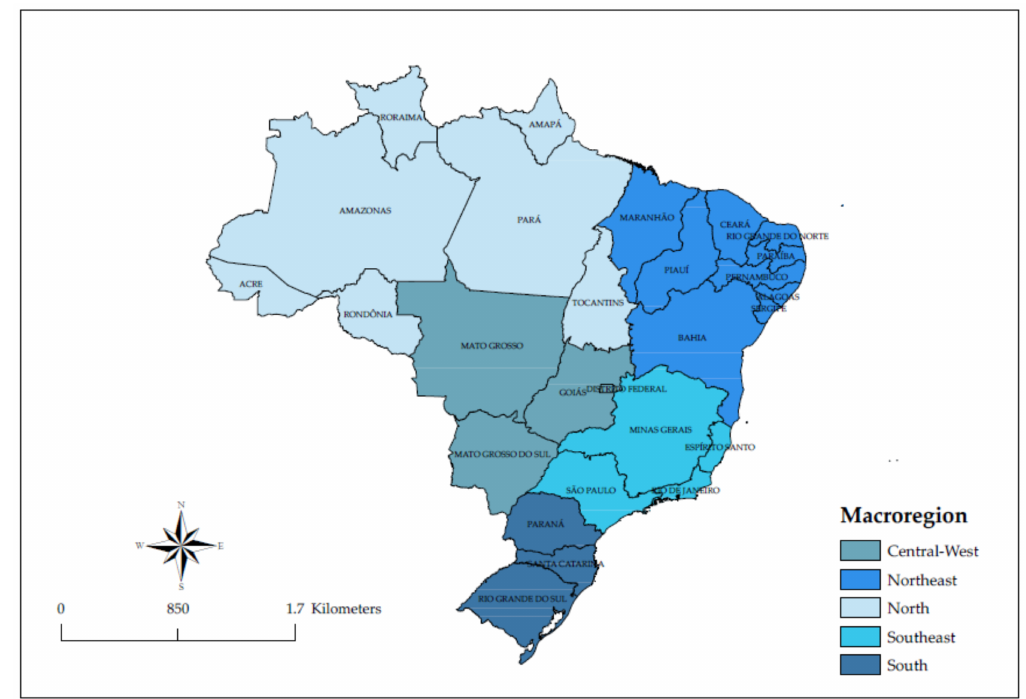
Figure 1. Geographic localization of Brazilian states and